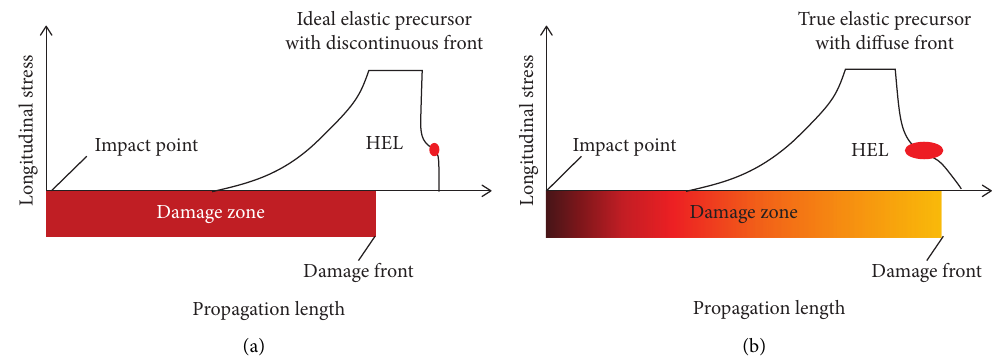
Figure 8: Two types of relative positions of elastic precursor and damage front. (a) The elastic precursor damage front is ahead of the damage front. (b) The elastic precursor with diffuse front and the damage front partly